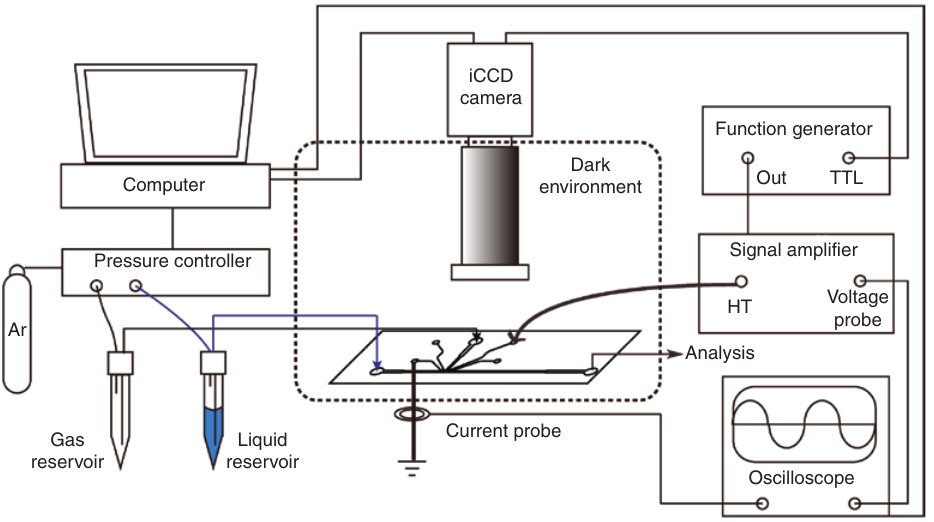
Figure 4: Schematic illustration of the experimental setup for optical measurement of the plasma microreactor.